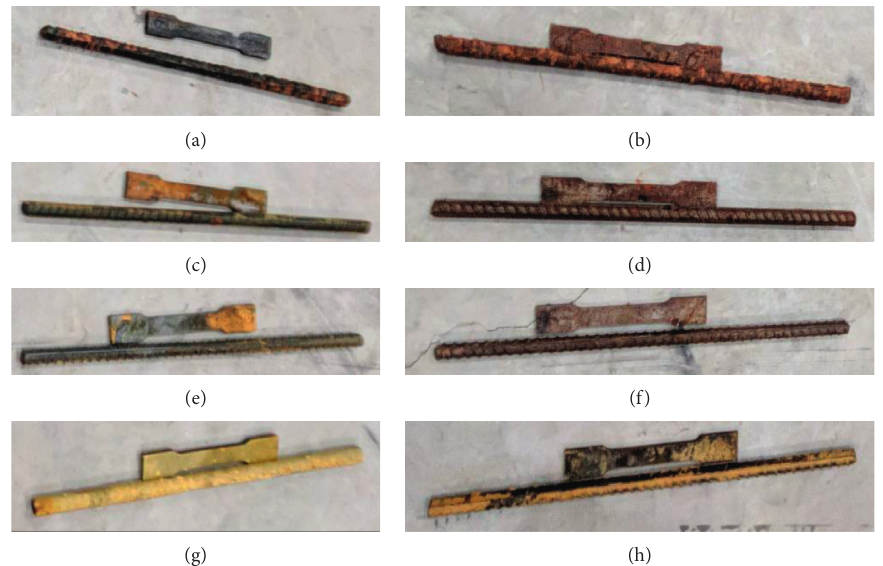
Figure 4: Steel bar and steel plate specimens after 300 d of corrosion: (a) immersion 0%, (b) dry-wet 0%, (c) immersion 0.27%, (d) dry-wet